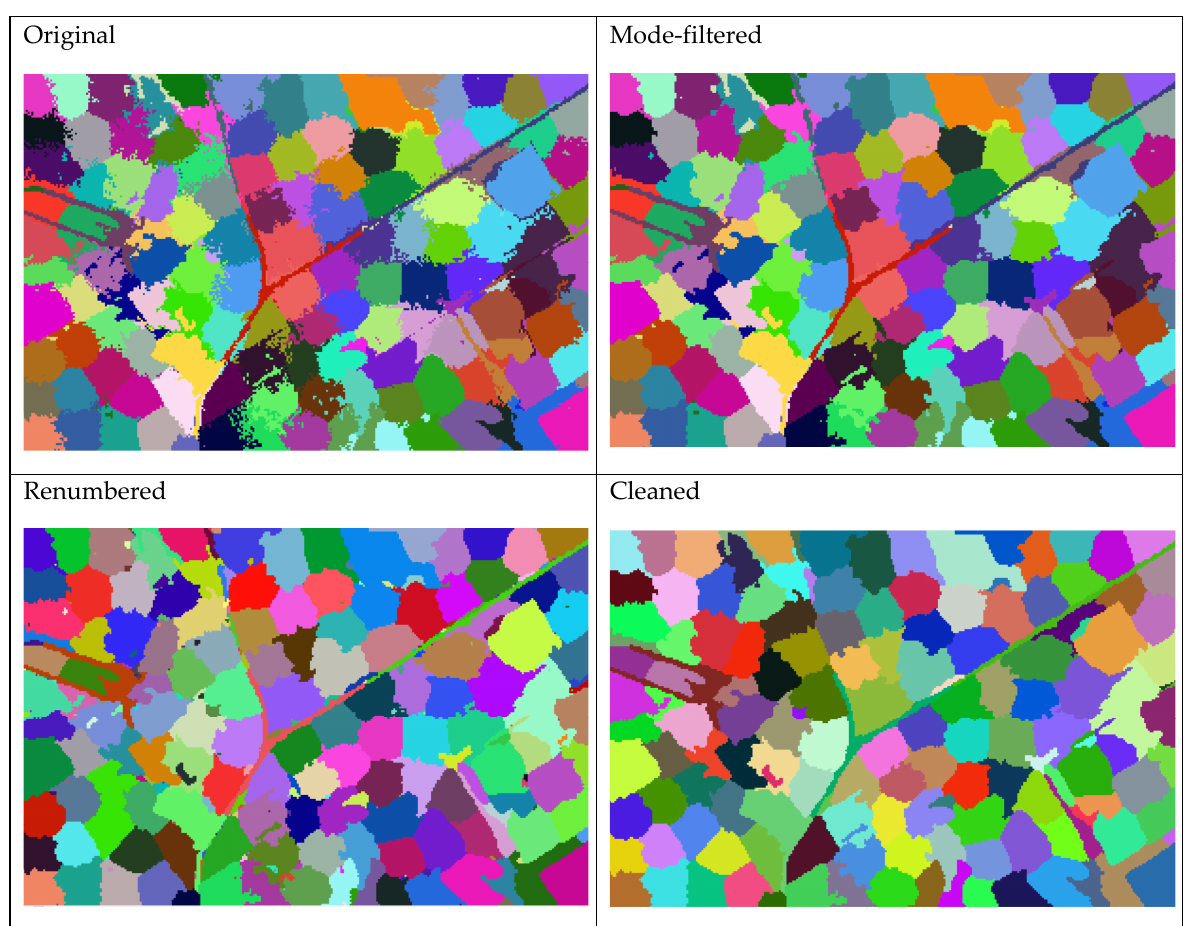
Figure 5. The effect of the post-processing steps (mode filtering, renumbering, and cleaning) on the segmentation produced by simulating annealing.